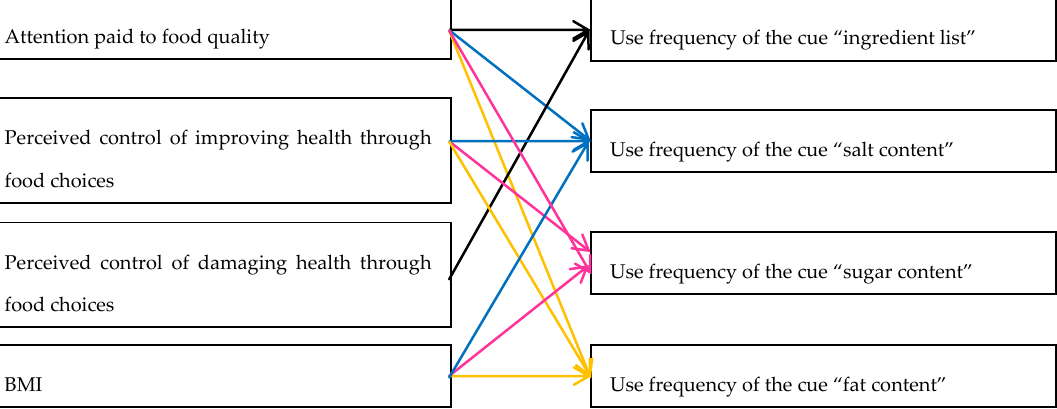
Figure 1. Model of observed determinants of the use frequency of food quality cues related to health, based on the results of standard linear regression.